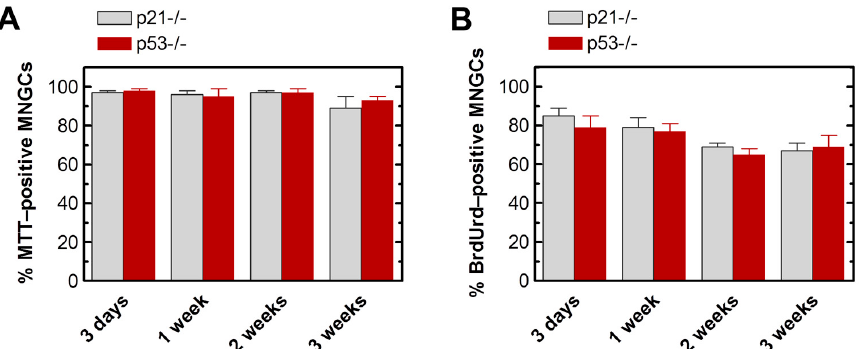
Figure 7. Percentages of: MTT-positive ( A ); and BrdUrd-positive ( B ) MNGCs in HCT116p21 − / − and HCT116p53 − / − cultures at indicated times after irradiation (8 Gy). Bars, SE.